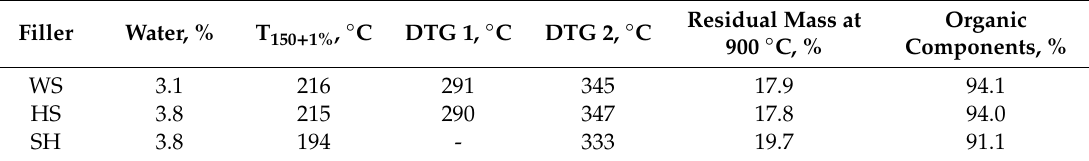
Table 1. Values determined based on thermogravimetric (TG) analysis conducted for WS, HS, and SH in nitrogen as well as air (organic components).